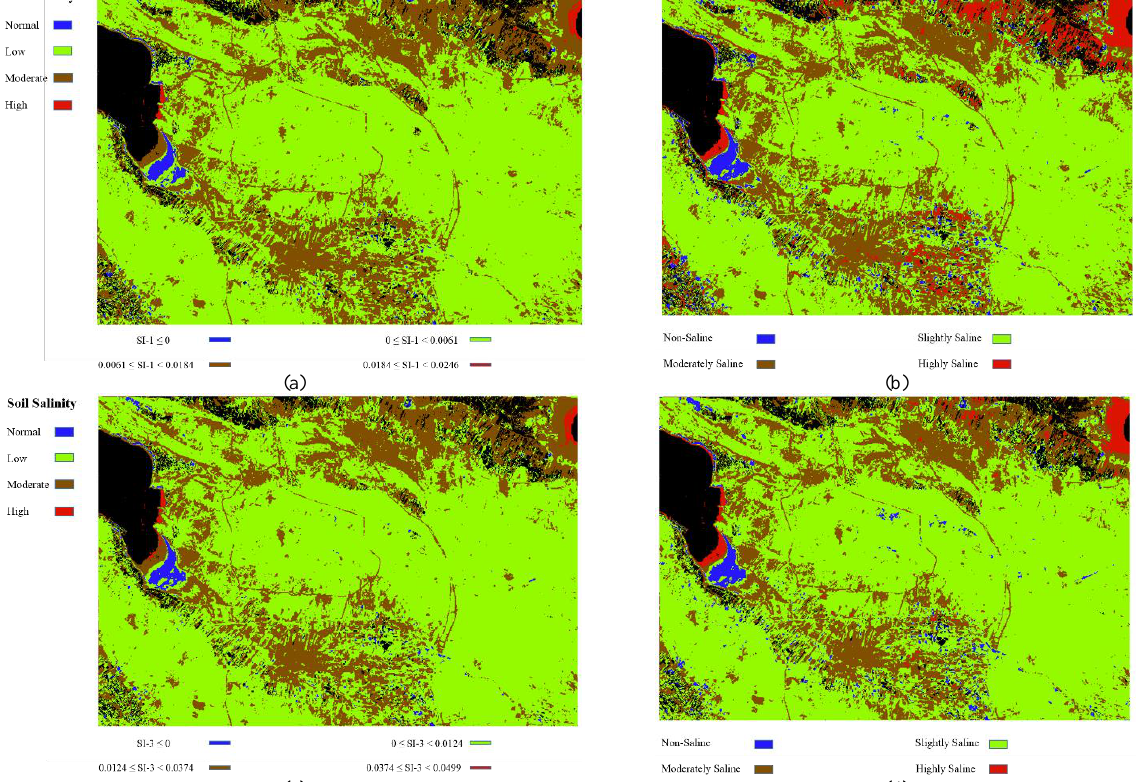
(d) Figure 6. Map of Salinity changes in bare soil lands based on pixel slopes during years 2000 to 2016, (a)SI-1 Slope, (b)K-Means on SI-1 Slope, (c) SI-3 Slope and (d)K-Means on SI-3